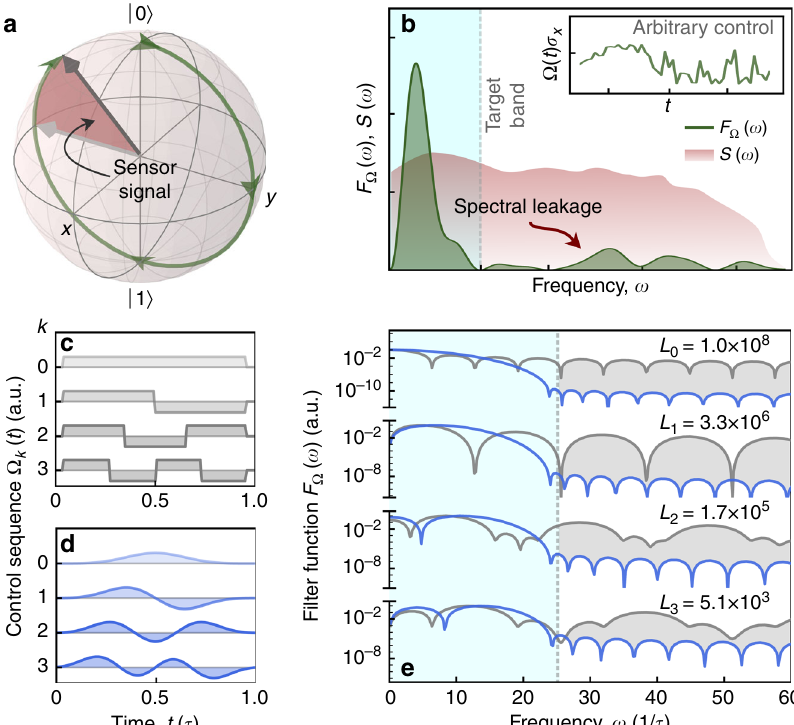
Fig. 1 Illustration of frequency response of time – domain control protocols. a Sensor signal for a driven qubit is derived from the spectral overlap of the noise and control, producing a detectable rotation error. b Sensor spectral response for a given control protocol (inset) may show leakage outside of the desired target band, which makes an undesired contribution to the signal in a . c , d Sample control sequences for fl at-top echo protocols and their DPSS-modulated counterparts. Orders shown here: k = 0, 1, 2, 3, and NW = 4. Note that k is equal to the number of zero crossings in the time domain and, by construction, odd-order pulses, with zero net rotation, have no DC susceptibility. e F Ω ( ω ) capturing the frequency response of the control envelopes in c , d . The dotted line indicates the boundary of the target band along the positive frequency axis, ω B = 2 π W / Δ t , where τ = N Δ t is the pulse duration. Inferior spectral concentration of fl at-top (FT) pulses, manifested as spectral weight beyond ω B , is highlighted with shading. Out-of-band power relative to k th order DPSS- (cid:1) (cid:3) (cid:1) (cid:3) R R ω B 1 = 1 (cid:3) λ DPSS modulated pulses is calculated as L k (cid:1) 1 (cid:3) λ FT k , where λ ‘ k ¼ d ω F ‘ Ω ð ω Þ = d ω F ‘ Ω ð ω Þ , for the appropriate k th order fi lter k 0 0